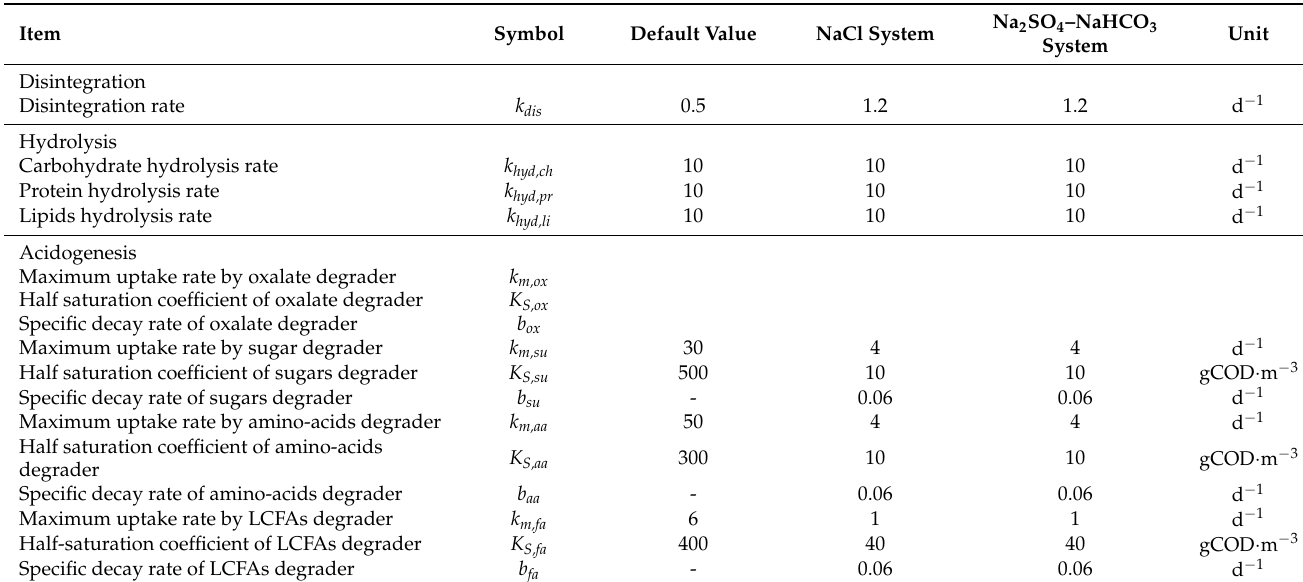
Figure 5. Measured and simulated results of MPR, VFAs, and particulate/soluble COD in the Na 2 SO 4 –NaHCO 3 system. Table 4. Kinetics for the anaerobic fermentation model of salt-accumulating plants including sulfate reduction.